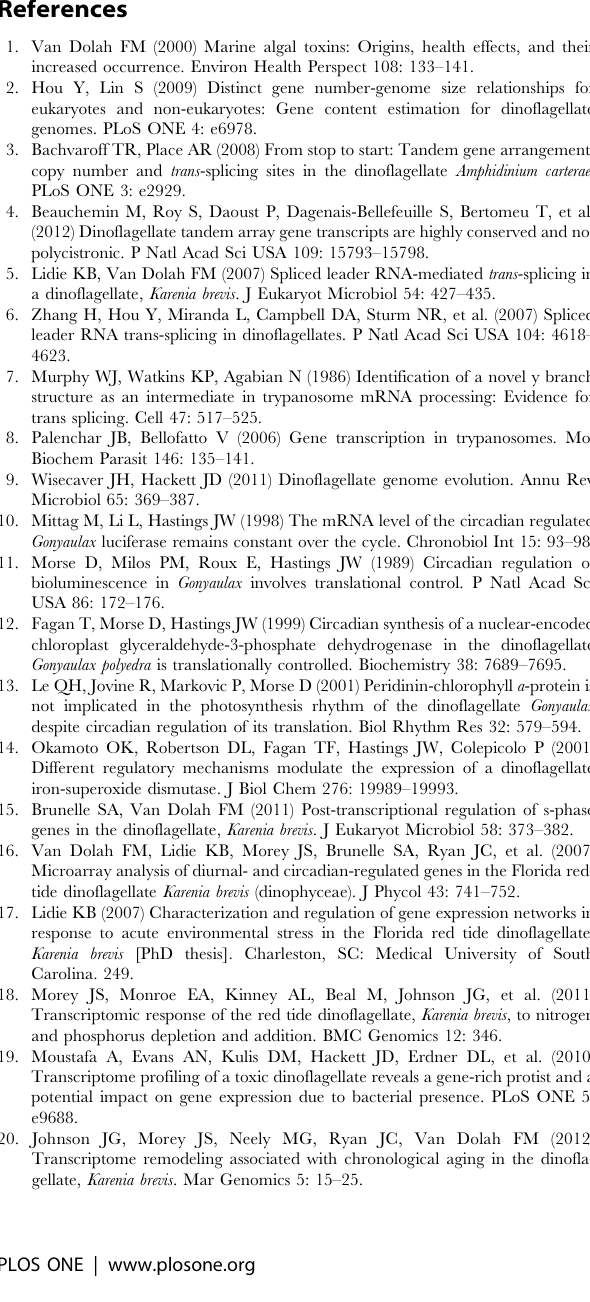
Table S1 Primers used for quantitative real-time PCR. Table S2 Half-lives for 7086 features passing quality filters based on newly synthesized RNA to pre-existing RNA